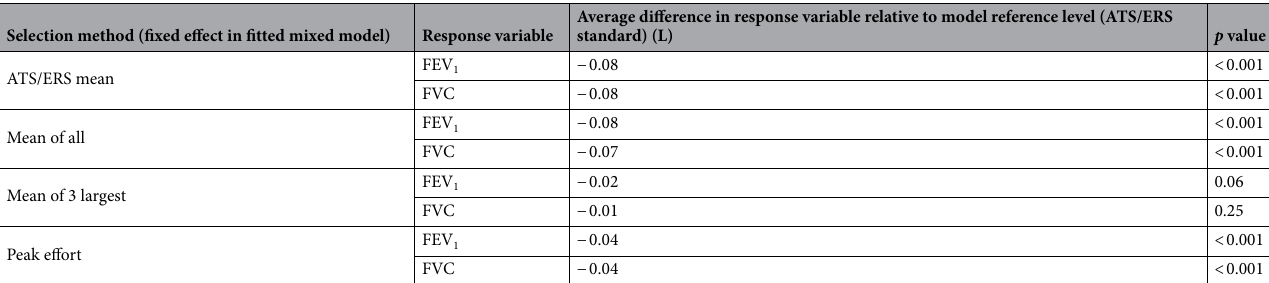
Table 6. Effect estimates from fitted linear mixed effects models for each forced vital capacity (FVC) and forced expiratory volume in one second (FEV 1 ). The effect estimate here represents the average difference in outcome variable (FEV 1 or FVC) between the alternative selection method versus the American Thoracic and European Respiratory Societies (ATS/ERS) standard method. A p value < 0.05 indicates the selection method was statistically significantly different from the ATS/ERS selection method.